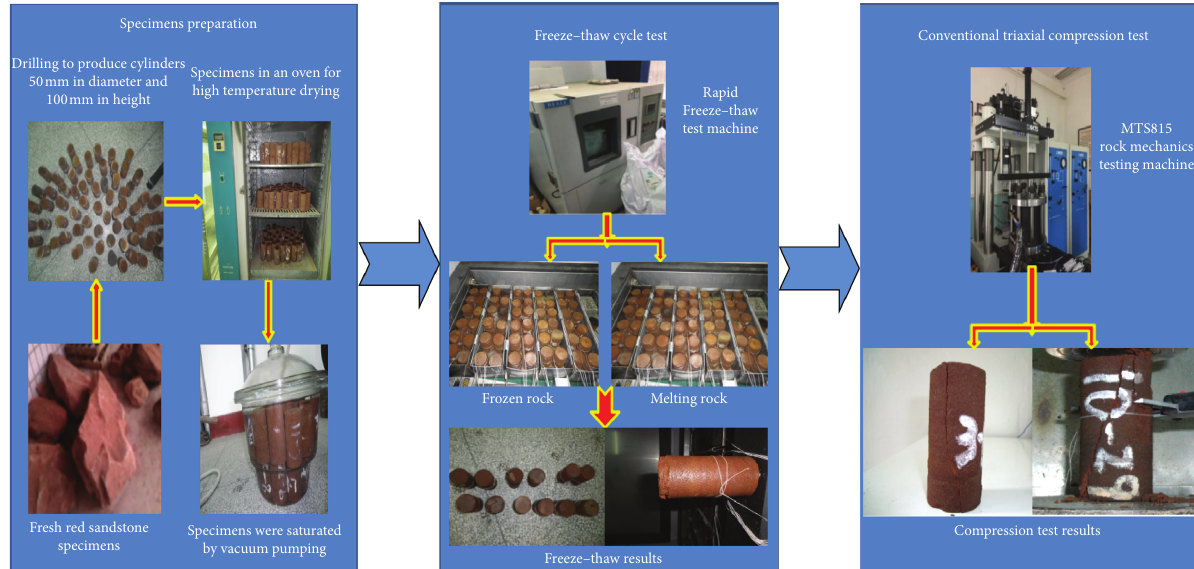
Figure 1: The freeze-thaw and conventional triaxial compression test process in a schematic